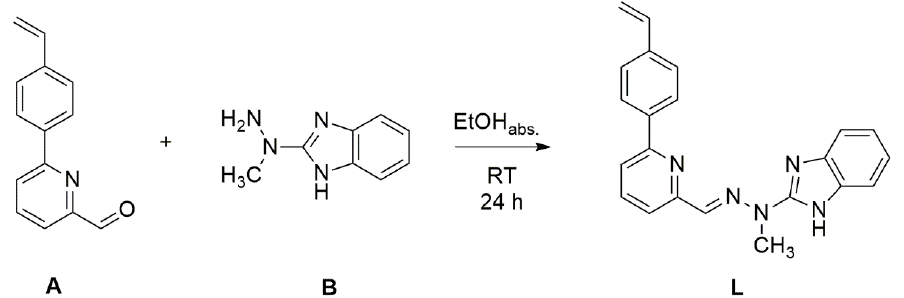
Figure 1. Synthetic scheme of preparation of L .